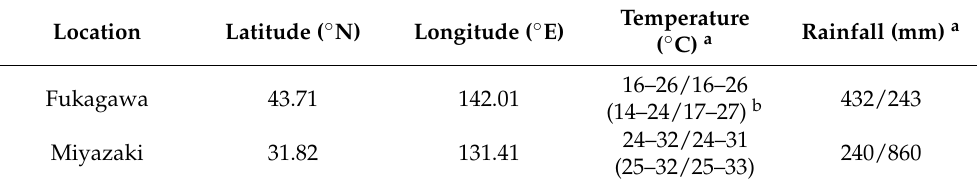
Table 2. Geographical and climatic characteristics of the study locations in Japan